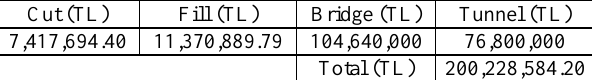
Table 16. Approximate total cost of constructing an alternative line on rolling land Table 20. Volume of earthworks required for the construction of